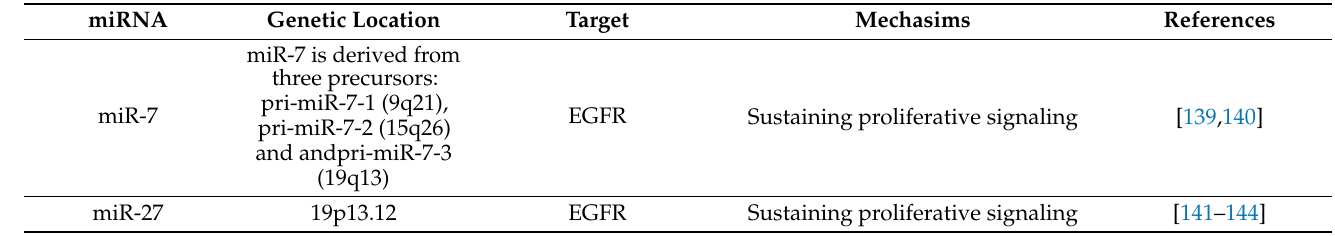
Table 3. miRNAs involved in the pathogenesis of lung